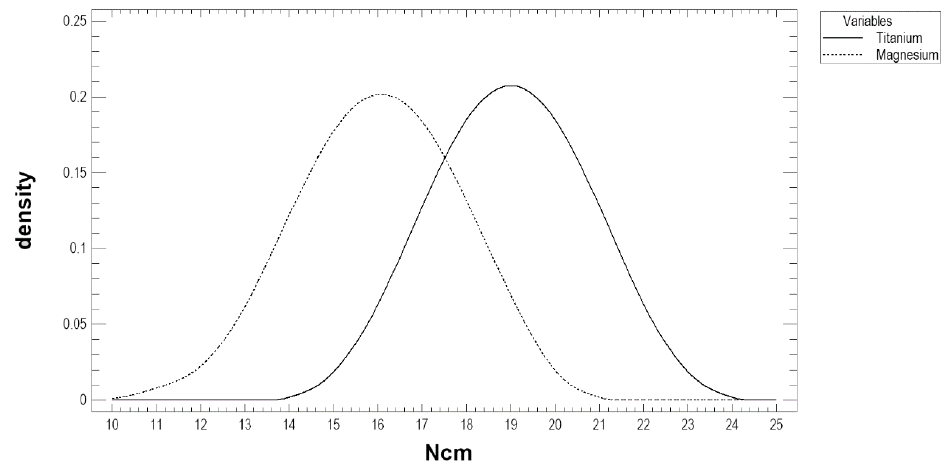
Figure 5. Maximal moment of the torque [N · cm] before the screw was damaged. The magnesium alloy screw is weaker than the titanium alloy screw ( p < 0.05).